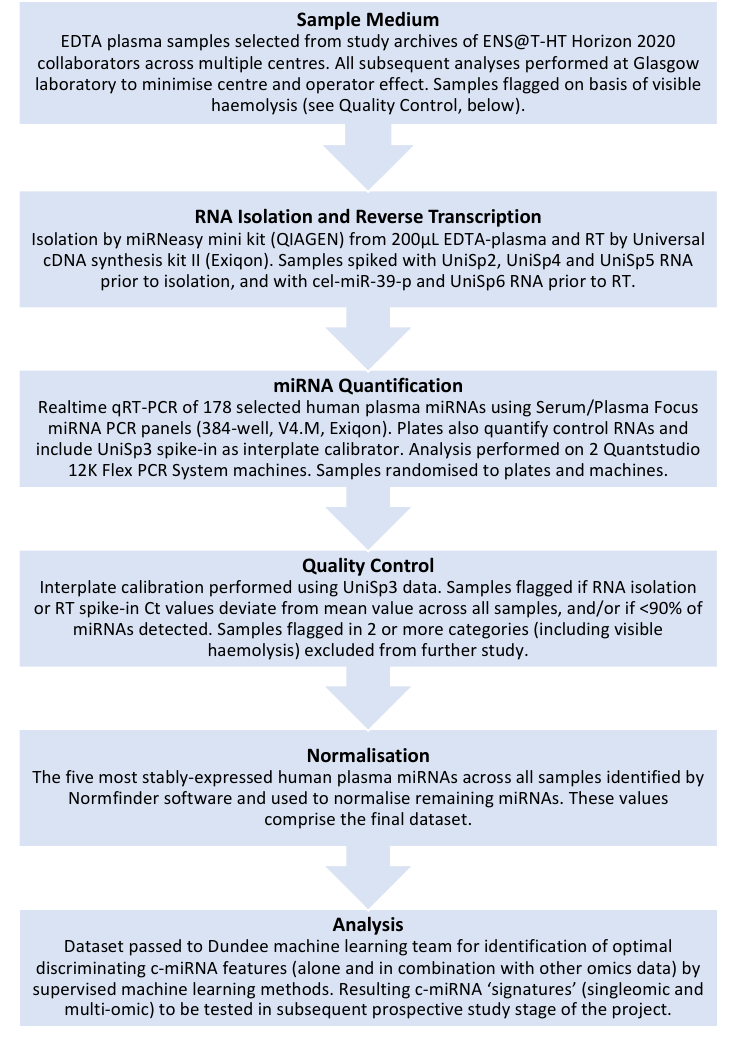
Figure 1. Summary of workflow for c-miRNA analysis in the retrospective ENSAT-HT study.